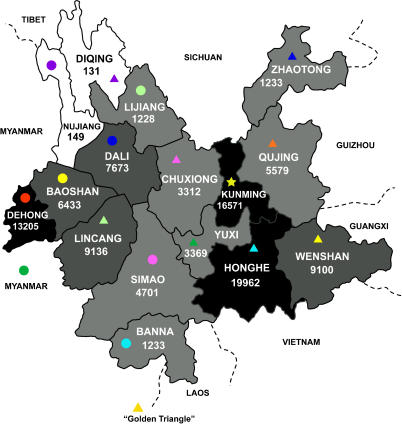
Map of the Yunnan Province of the People's Republic of China and Distribution of Reported Cases of HIV-1 Infection in 2004The color-coded symbols represent the geographic origins of HIV-1 strains as depicted in Figures 2, 3, and 6.